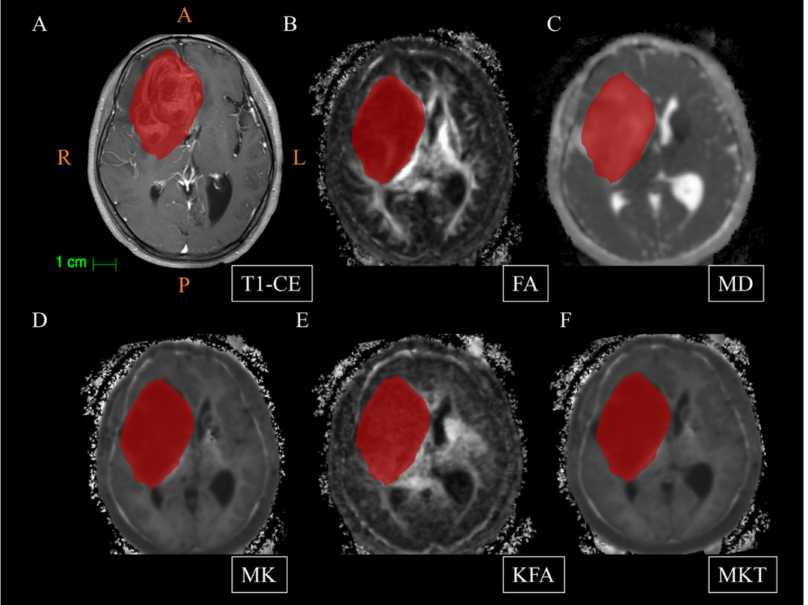
Figure 1. Delineation of volumes of interest (VOIs). A 60-year-old man with glioblastoma (WHO grade IV). ( A ): The lesion shows significant inhomogeneous enhancement on axial T1-weighted enhancement imaging. ( B – F ): fractional anisotropy (FA) parameter maps, mean diffusivity (MD) parameter maps, mean kurtosis (MK) parameter maps, kurtosis fractional anisotropy (KFA) parameter maps, and mean kurtosis tensor (MKT) parameter maps, respectively (the VOIs are outlined in red on each parameter image). A: Anterior; P: Posterior; R: Right; L: